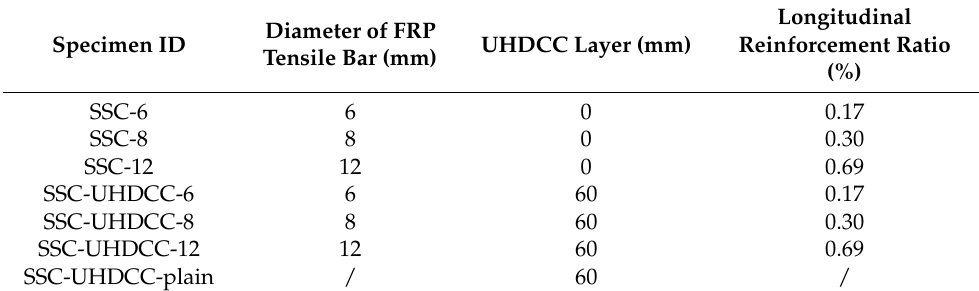
Table 5. Properties of test specimens.